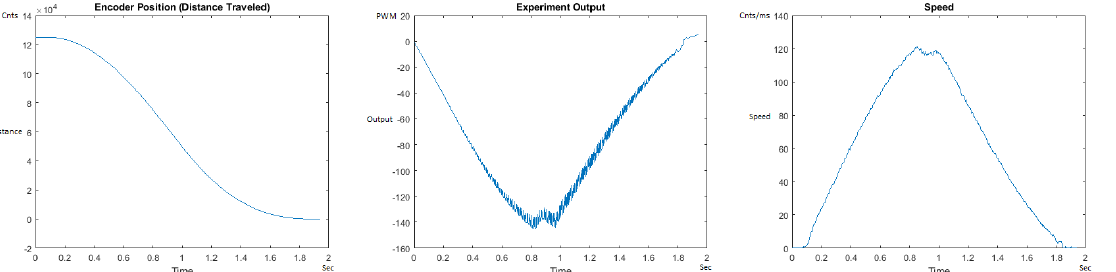
Figure 29. Encoder position, output and speed plots for PID++ DOWN operation— Vmax 120 cnts/ms, Adesired 0.040 cnts/ms 2 —10